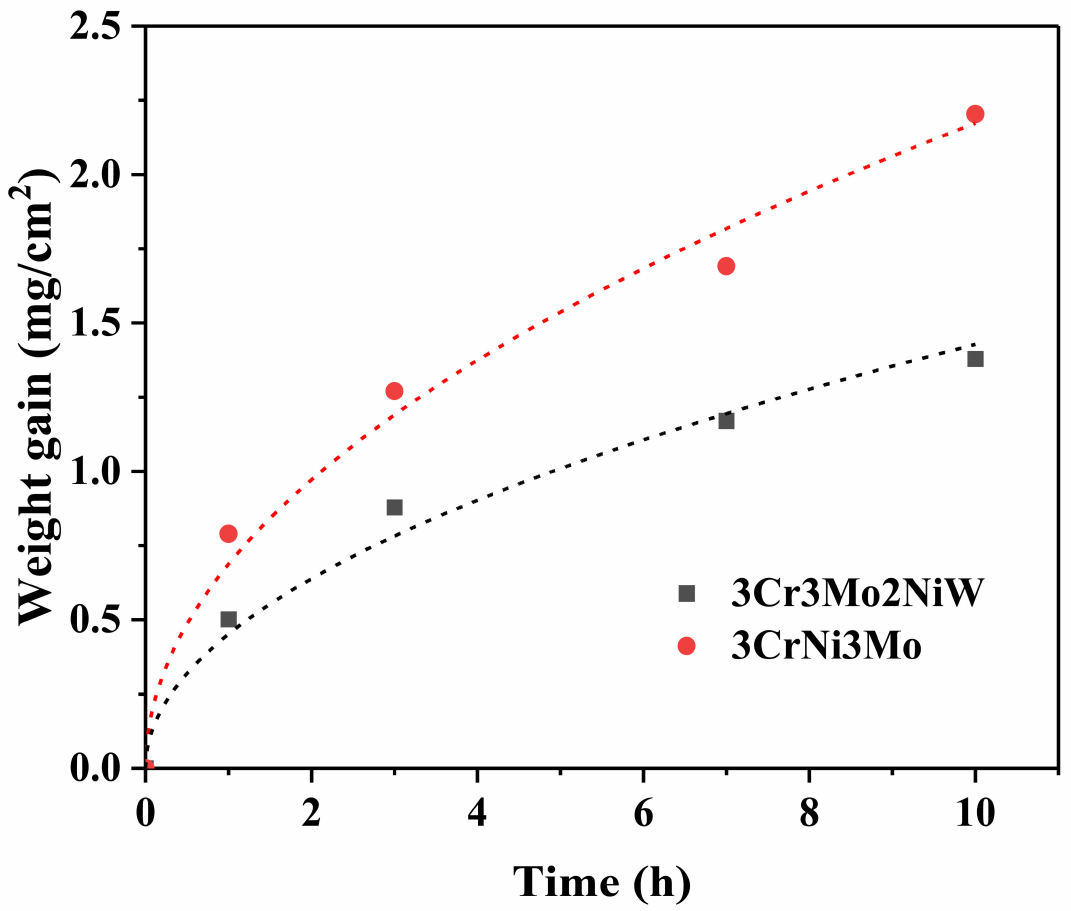
Figure 2. Weight gain as a function of exposure time for the oxidation of two Cr-Ni-Mo hot-work die steels at 600 ◦ C. The lines show the fit to cubic oxidation